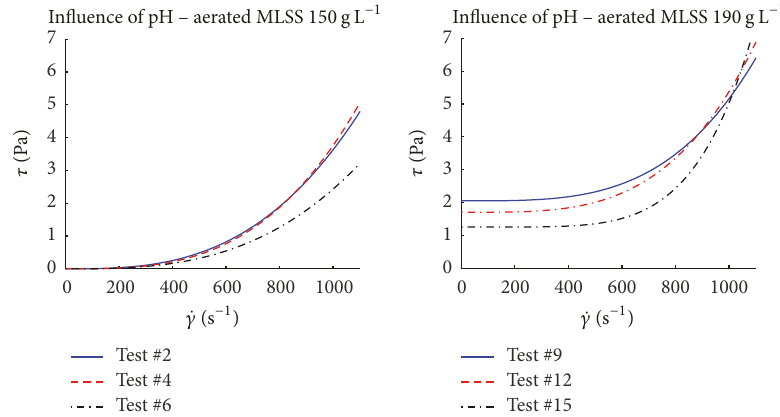
Figure 11: Shear stress versus rate of deformation: influence of pH for aerated